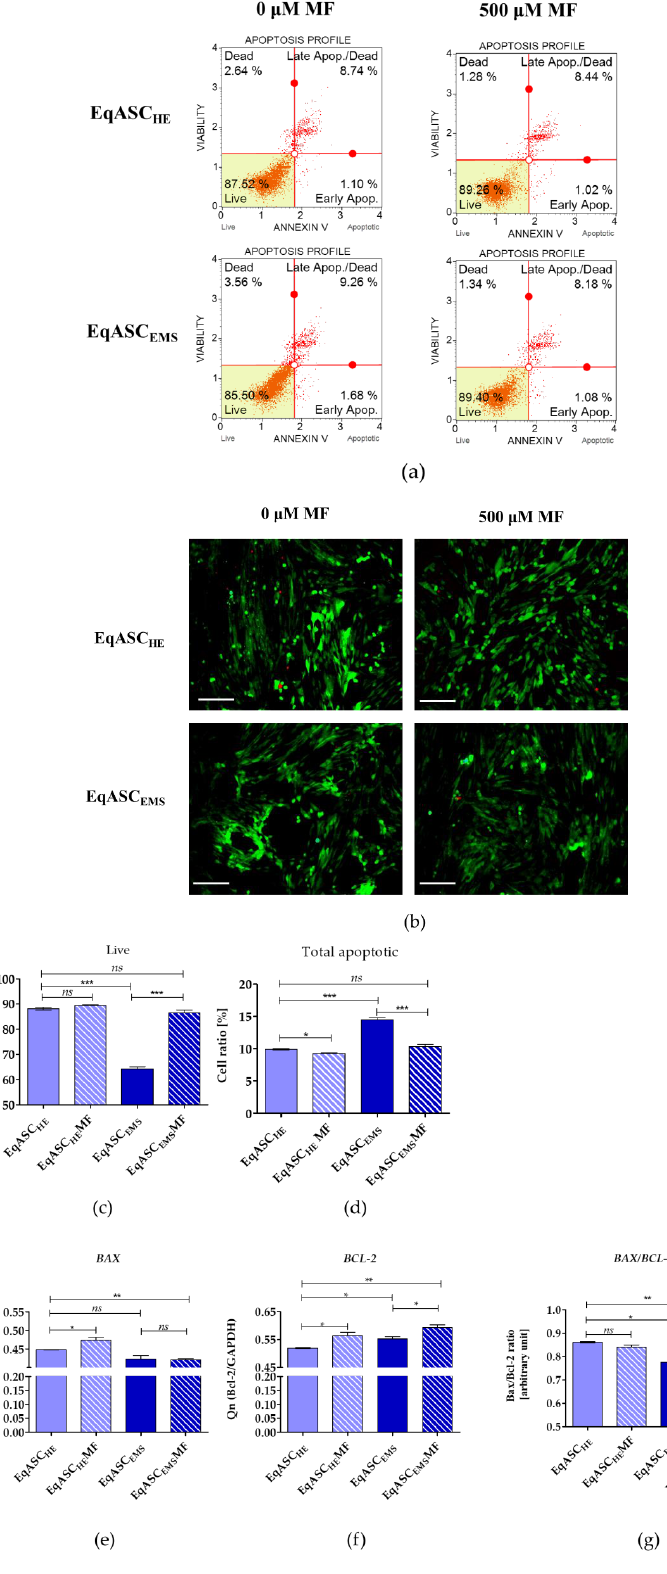
Figure 4. The influence of metformin on the apoptosis profile. Representative dot plots indicating distribution of cells after annexin V/ propidium iodide staining ( a ) Representative images obtained after calcein/PI staining, scale bar — 250 μ m. ( b ) Analysis of cell viability ( c ) and apoptosis ( d ). Measured transcript levels for BAX ( e ) BCL-2 ( f ) and their ratio ( g ) Statistically significant changes are indicated with asterisks: * p < 0.05; ** p < 0.01 and *** p < 0.001, while non-significant differences are marked as ns .